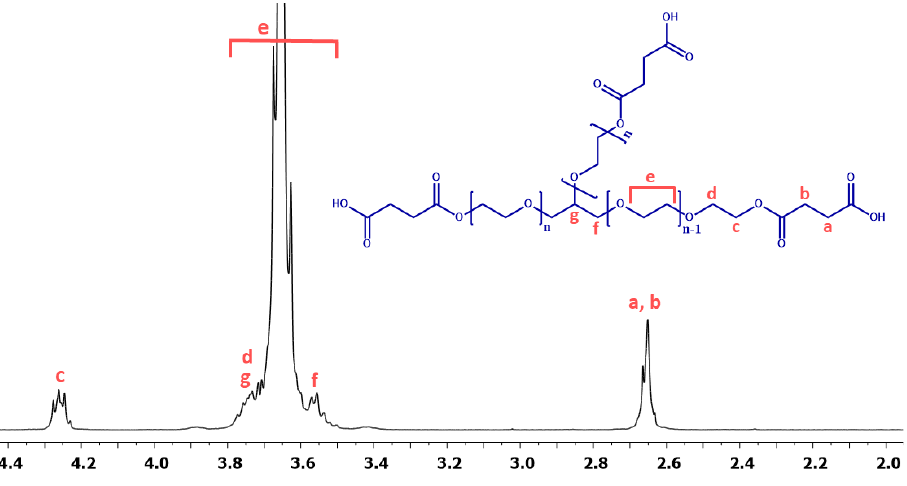
Figure 3. 1 H NMR and spectrum of PEC_COOH.